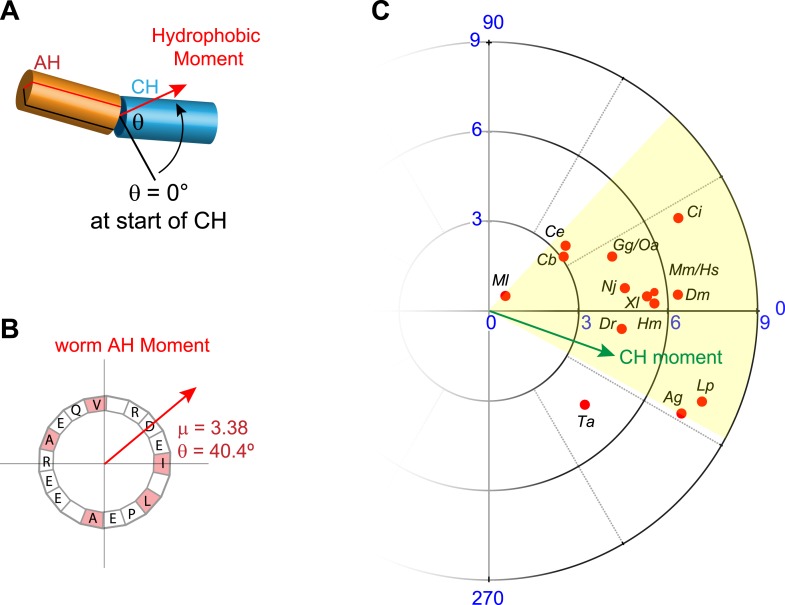
Conservation of hydrophobic moments of complexin.(A) The AH hydrophobic moment was computed with angular orientation relative to the first residue of the CH. (B) Example of a hydrophobic moment for a particular AH (worm). (C) Polar plot of the hydrophobic moments for 16 species (red) and rescuing constructs (turquoise). All species besides Trychoplax cluster in a small range of orientations (yellow). The moment of the worm CH is shown in green. The 16 species shown are Trichoplax adhaerens Ta, Mnemiopsis leidri Ml, Caenorhabditis elegans Ce, Caenorhabditis briggsae Cb, Drosophila melanogaster Dm, Anopheles gambiae Ag, Loligo pealei Lp, Hirudo medicinalis Hm, Narke japonica Nj, Ciona intestinalis Ci, Danio rerio Dr, Xenopus laevis Xl, Gallus gallus Gg, Ornithorhynchus anatinus Oa, Mus musculus Mm, and Homo sapiens Hs.